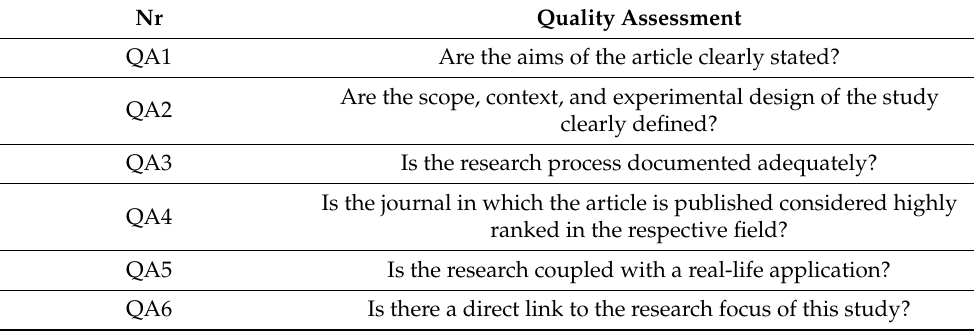
Table 2. Quality assessment per article, adapted from